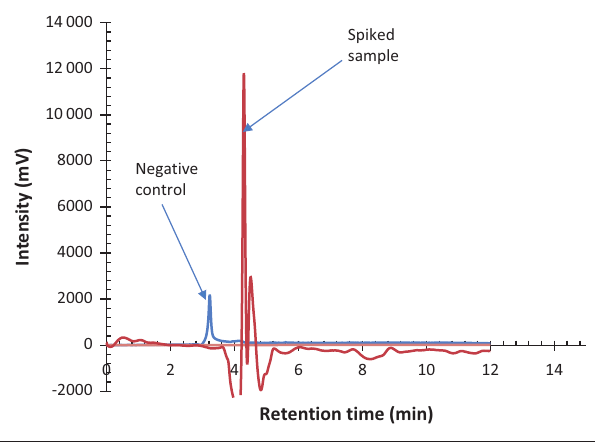
FIGURE 1: Combined chromatogram of the negative control sample (without oxytetracycline) and the sample spiked with 10 mg/kg 20 % oxytetracycline.